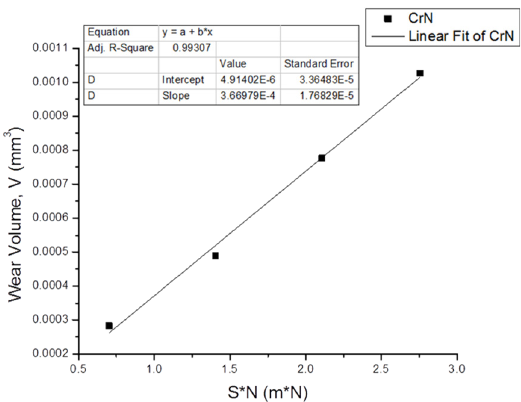
for k determination in the non-perforating C C